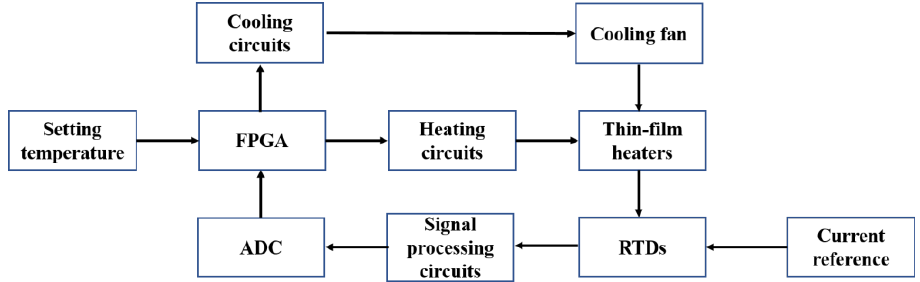
Figure 4. Block diagram of the control processes.